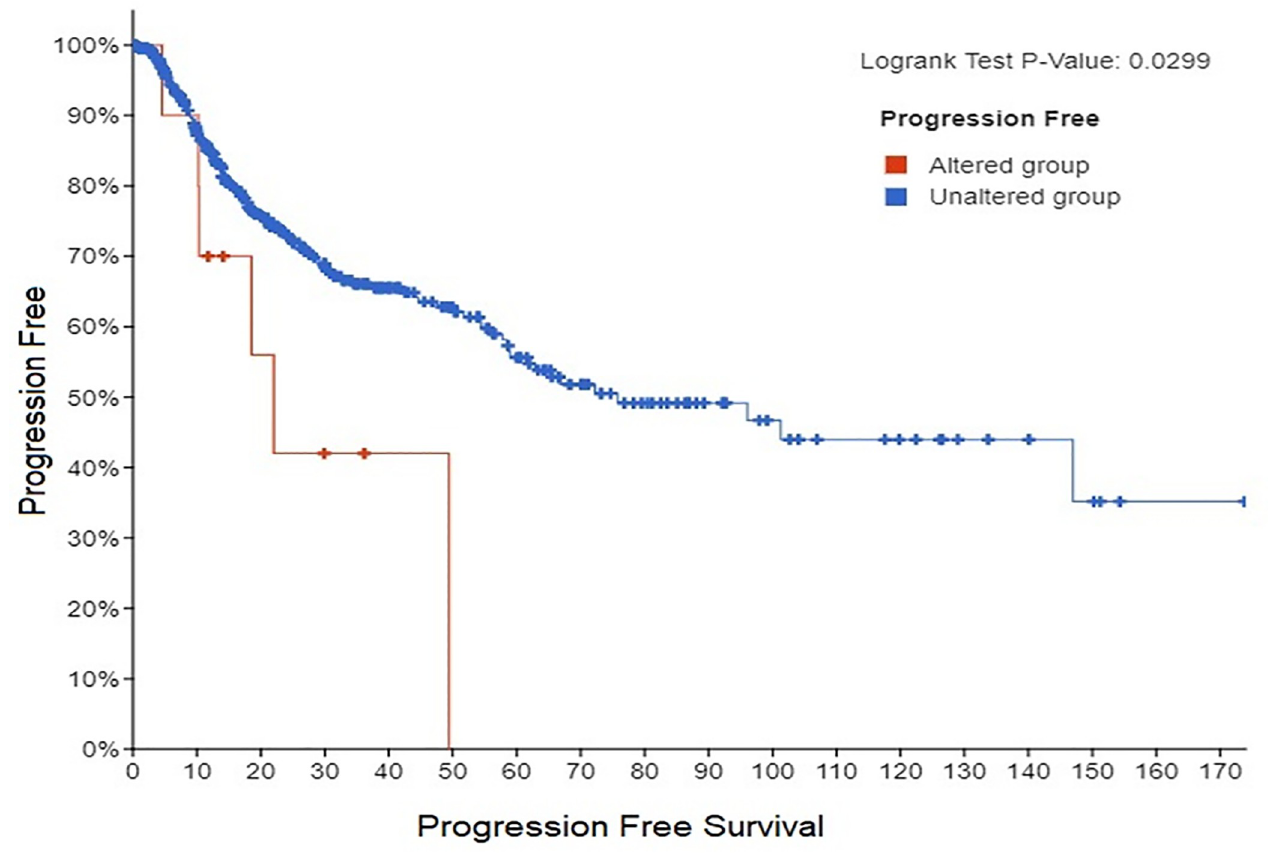
Fig 8. Kaplan-Meier plot of disease-free survival in CAV-1 altered (Red), and CAV-1 unaltered (Blue) group in lung cancer patients.